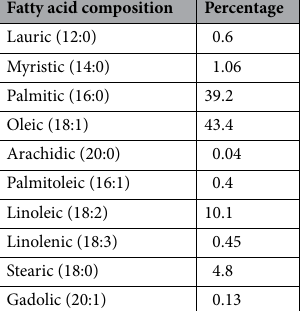
Table 2. Chemical composition of palm biodiesel by GC–MS analysis.